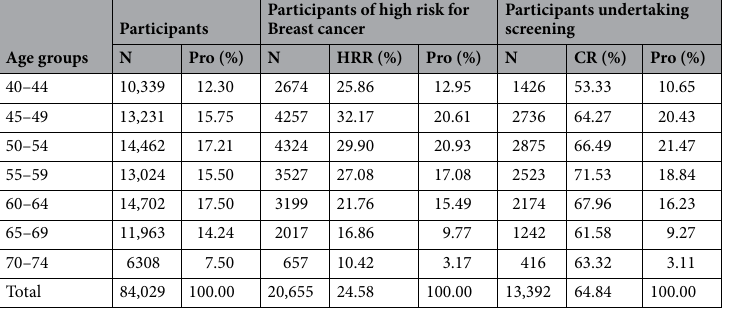
Table 3. Baseline breast cancer screening in Urban Hebei Province. N number of cases, Pro proportion, HRR high risk rate, CR compliance